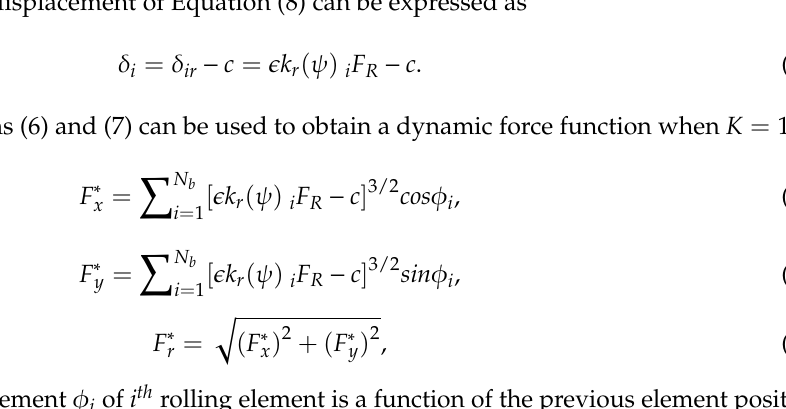
Figure 3. Load distribution with different clearances.